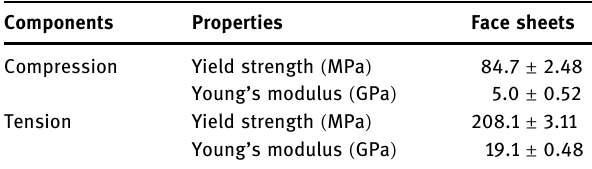
Table 2: Material properties of face sheets